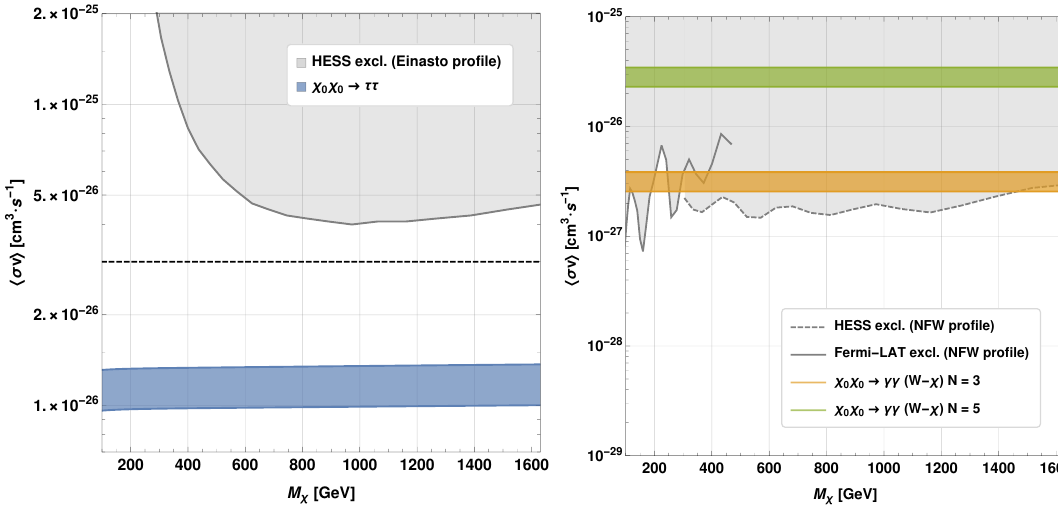
Figure 8 . Left: velocity-averaged DM-annihilation cross section to (cid:28)(cid:28) at present time. The grey area denotes the region excluded by HESS [94], whereas the blue band represents the prediction in our model. The dashed line is the value required for h (cid:27)v i 0 to saturate the (cid:10) h 2 constraint. Right: W (cid:0) (cid:31) contribution to (cid:27) ( (cid:31) 0 (cid:31) 0 ! (cid:13)(cid:13) ) for N = 3 ; 5 and corresponding bounds from HESS [95] and Fermi-LAT [96]. See text for further